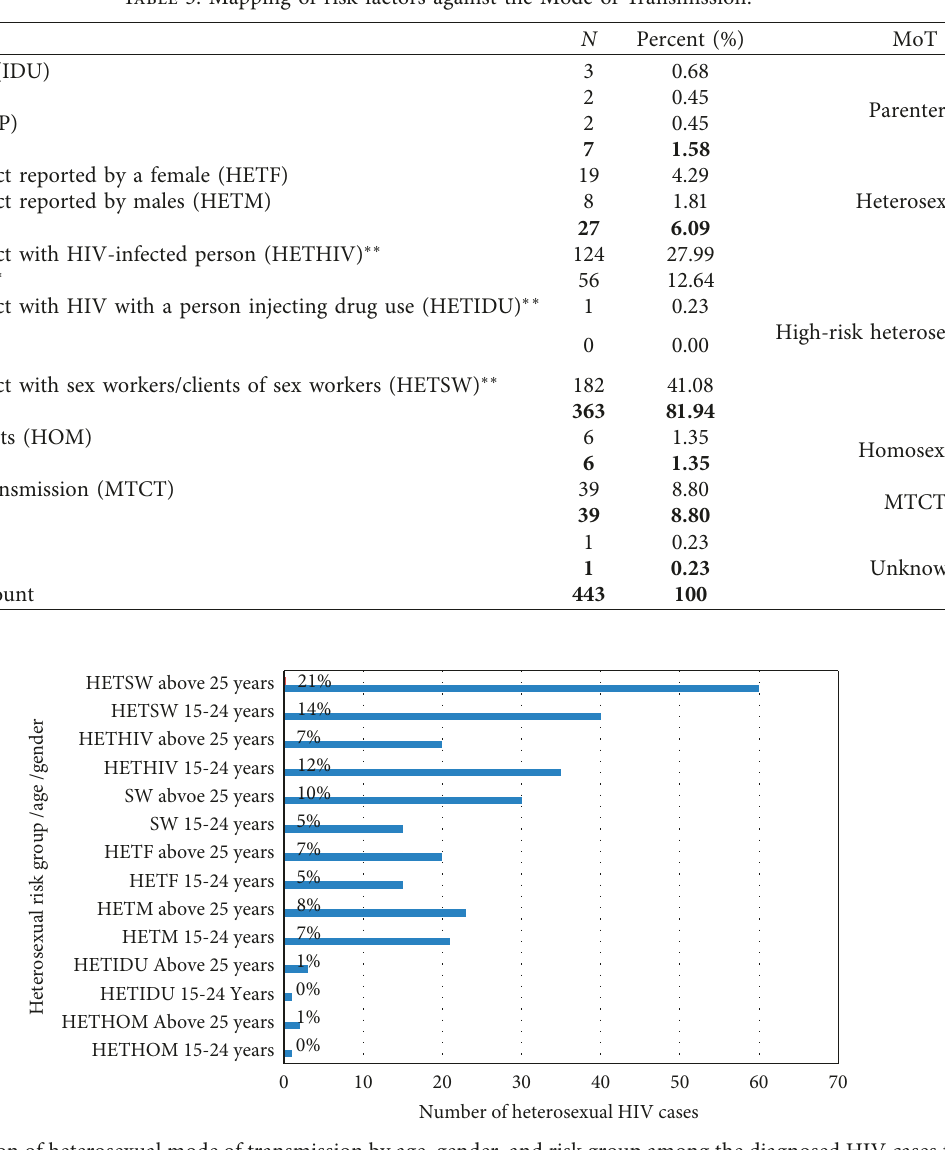
Table 3: Mapping of risk factors against the Mode of Transmission.